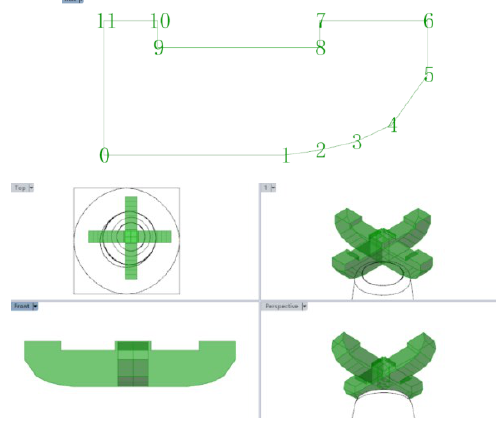
Figure 5. 1 st level of Bracket Set with inner arm